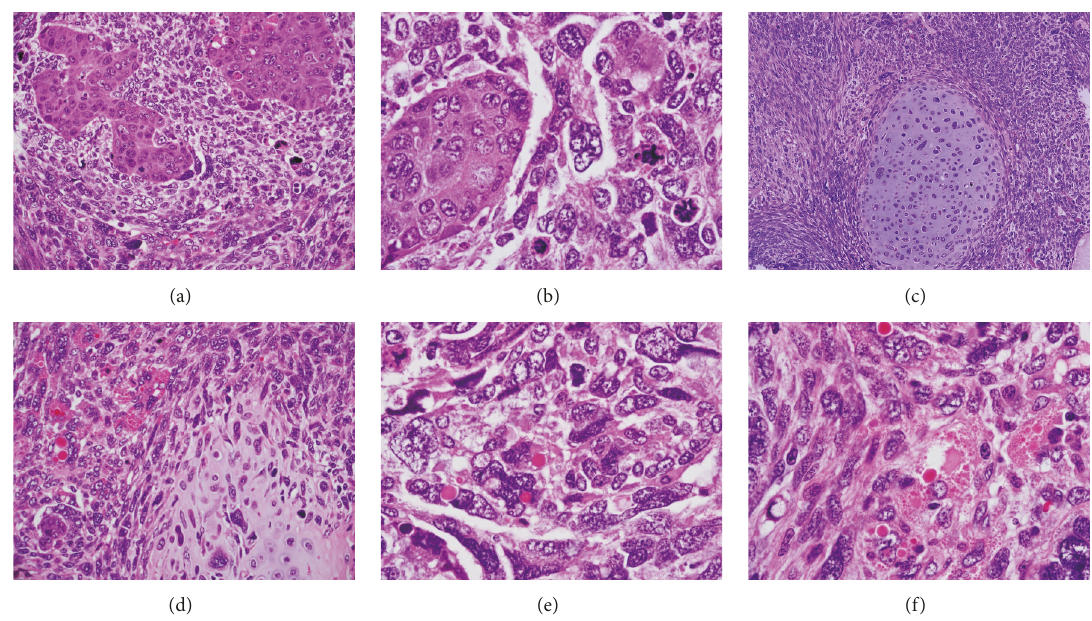
Figure 2: (a) Solid nests of malignant epithelial cells surrounded by malignant mesenchymal cells with pleomorphic nuclei and mitotic figures. H&E x200. (b) Solid nest of malignant epithelial cells with squamoid features surrounded by pleomorphic sarcomatous cells with bizarre nuclei. Note the presence of three atypical mitotic figures. H&Ex400. (c) An island of malignant cartilage with malignant chondrocytes featuring pleomorphic large nuclei, surrounded by spindly sarcomatous cells. H&E x200. (d) Island of malignant cartilage with adjacent pleomorphic sarcomatous cells containing eosinophilic hyaline globules 9Thanatosomes). H&E x200. (e) Intracytoplasmic eosinophilic hyaline globules (Thanatosomes) within the cytoplasm of sarcomatous cells. H&E x400. (f) Numerous eosinophilic hyaline globules (Thanatosomes), some are extruded into adjacent stroma. H&E